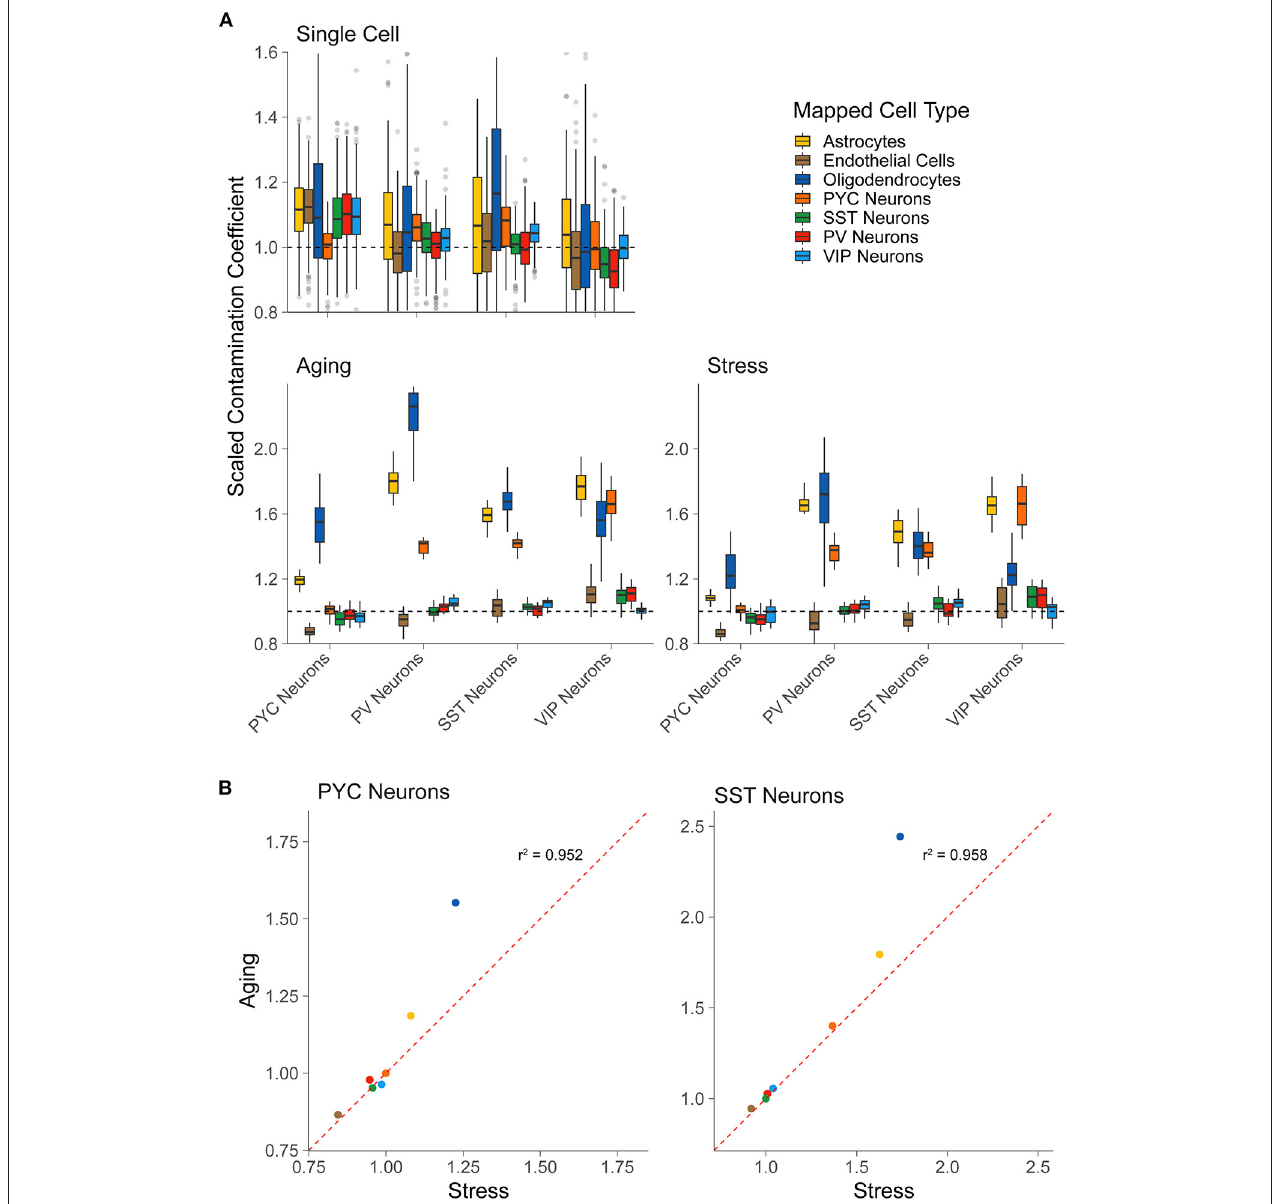
FIGURE 2 | LCM-seq but not scRNA-seq shows off-target cell-type marker expression. (A) Scaled contamination coefficients for an alternative scRNA-seq dataset (Tasic et al., 2016) that was not used previously as reference data (top row), the LCM-seq Aging dataset, and the LCM-seq Stress dataset (bottom row, left to right). Y-axis values are scaled to 1.0, which indicates the expected amount of off-target cellular marker expression if the sample was behaving exactly as expected for its “actual” cell type [based on the scRNA-seq reference data from Tasic et al. (2018)]. The “actual” cell type (for which the sample was enriched) is on the x-axis and the groups represent the reference cell type from single cell reference data. (B) Scatterplots for the scaled contamination coefficients in the Stress and Aging LCM-seq datasets for samples enriched for pyramidal cells (PYC Neurons) and SST interneurons (SST Neurons). Each point reflects the off-target cell type group averages shown in (A)